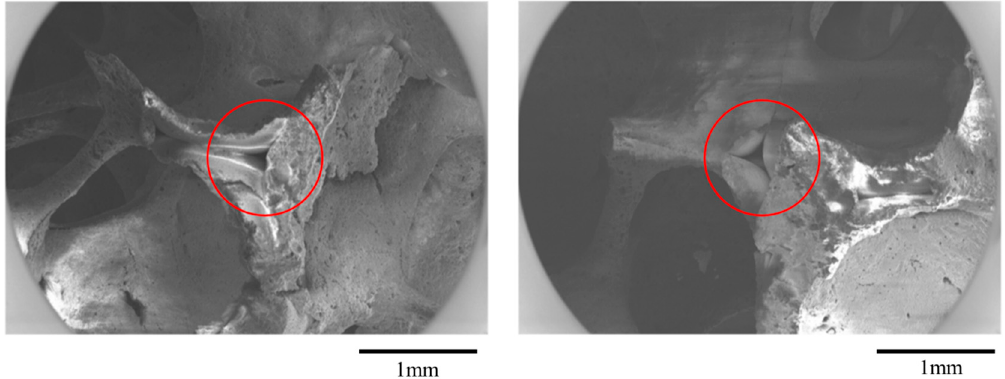
Figure 3. Scanning Electron Microscopy (SEM) micrograph of a triangular pore in a CFF that remained after burning out the impregnated foam.